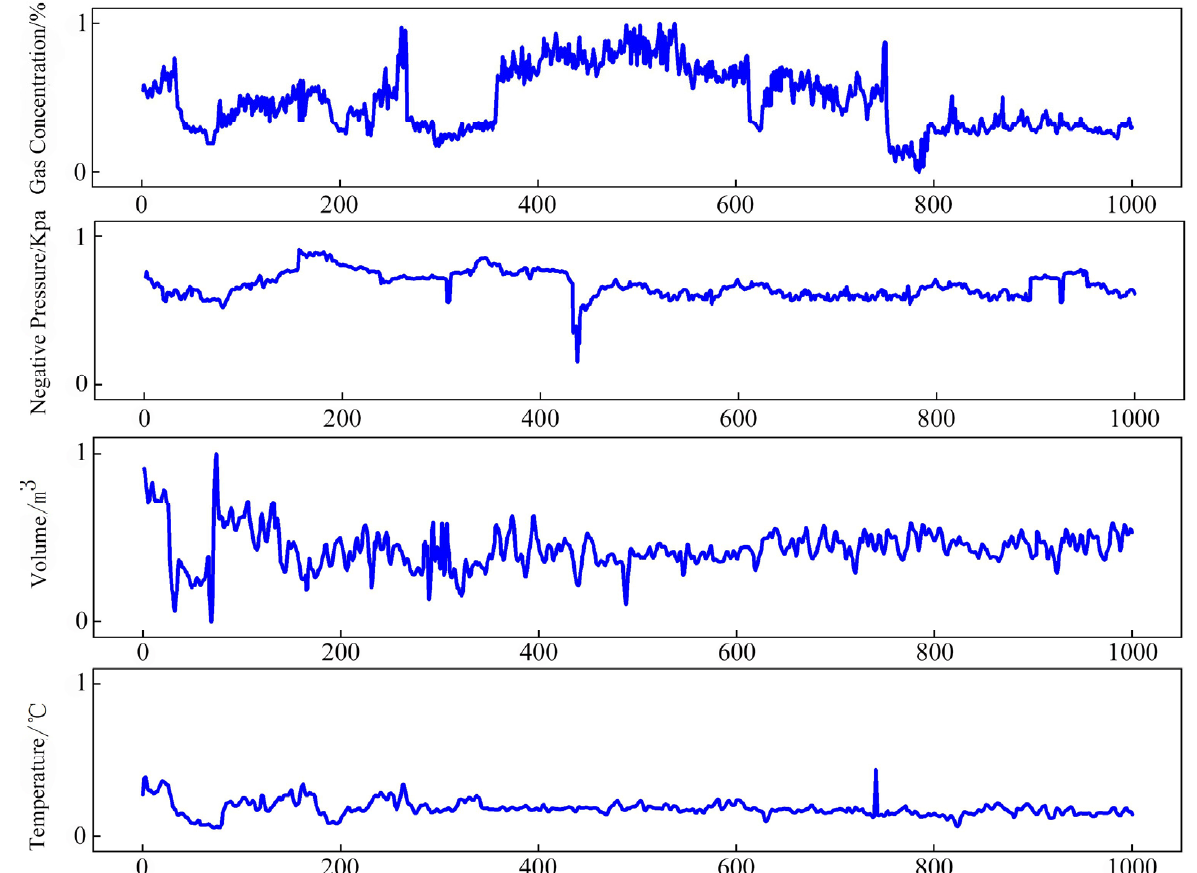
Figure 3. Processed data.